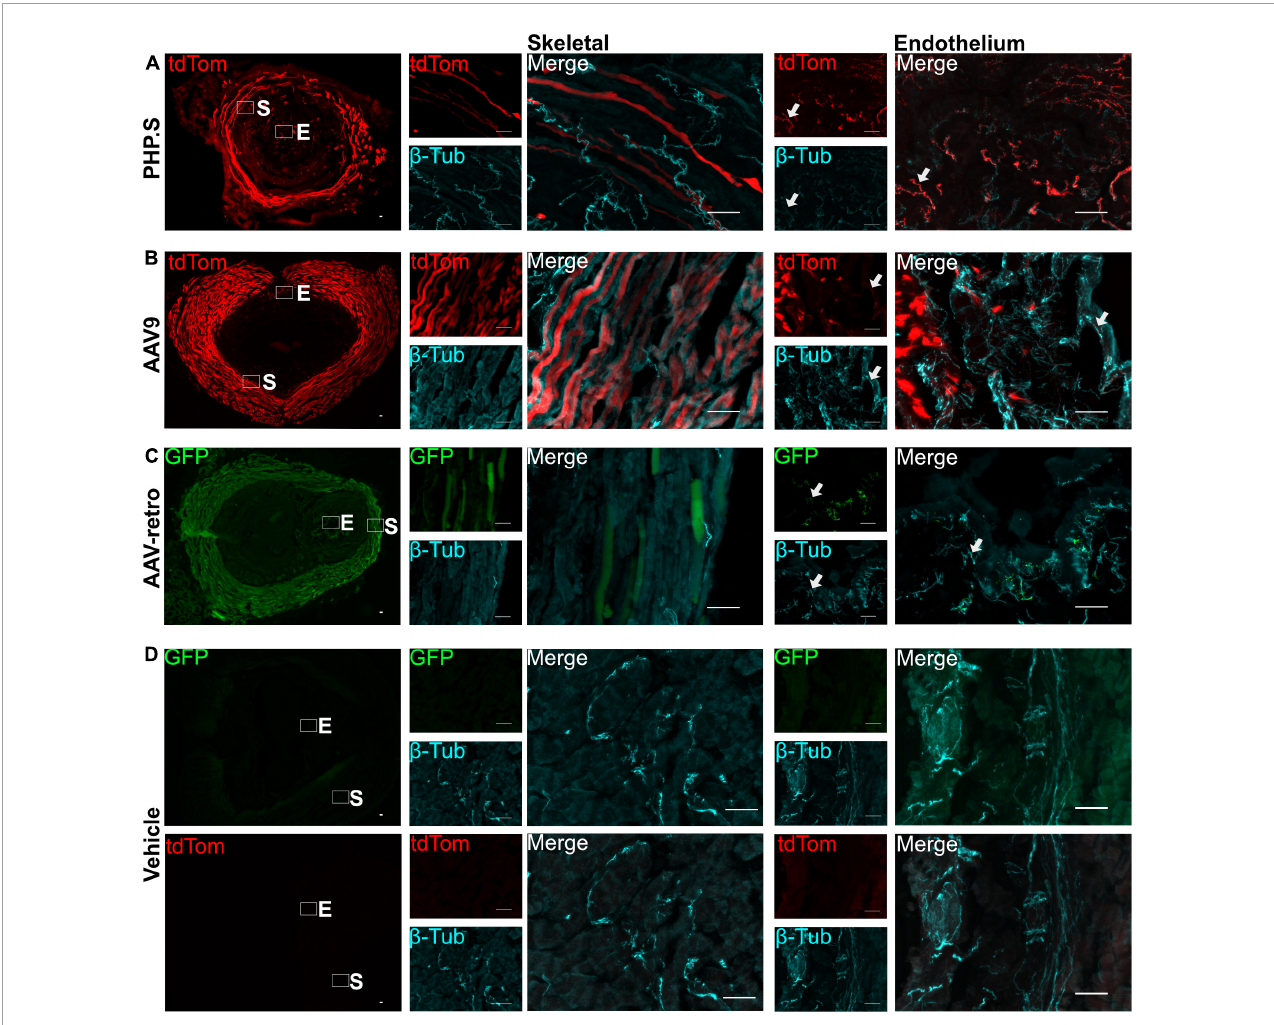
FIGURE5 Nerve fibers and non-neuronal cells are transduced by PHP.S, AAV9, and adeno-associated viruses (AAV)-retro in the external urethral sphincter. Representative images of tdTomato (A,B) or GFP (C) expression in the external urethral sphincter (EUS) (scale bar, 500 µ m). Skeletal (S) and endothelium (E) squares are magnified to display expression in the skeletal muscle layers and nerve fibers in the endothelium (scale bar, 50 µ m). (D) Images of EUS from vehicle-injected rats showing the corresponding fluorophore channels for GFP and tdTomato as well as skeletal muscle and endothelial magnifications (scale bar, 50 µ m). White arrows indicate transduced nerve